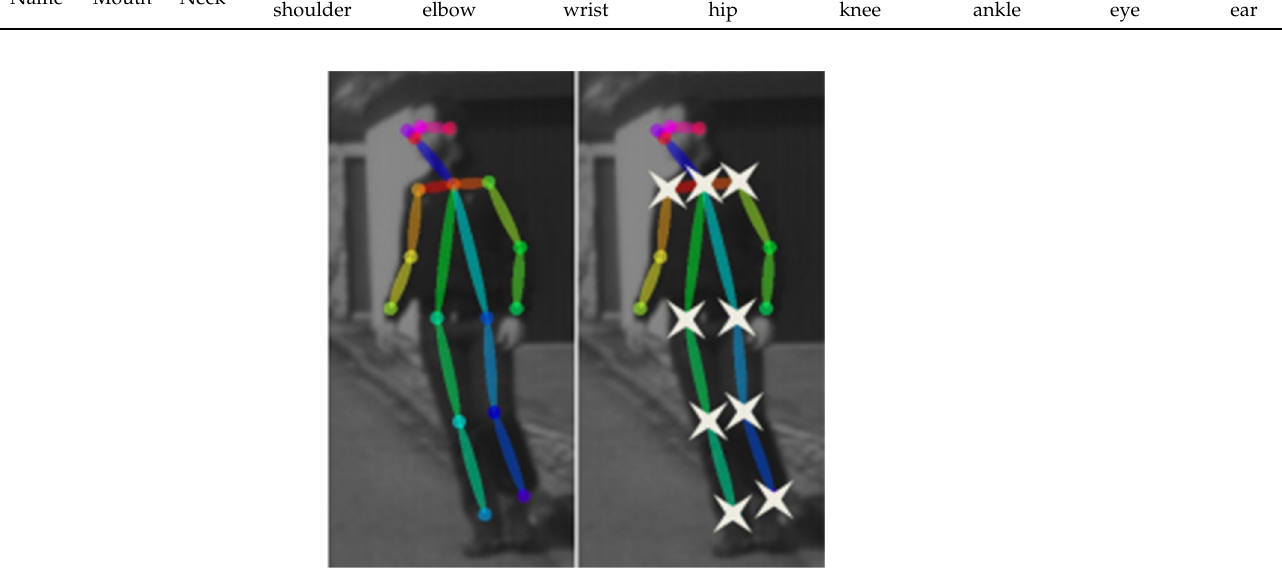
Figure 3. Key points for stable identification.